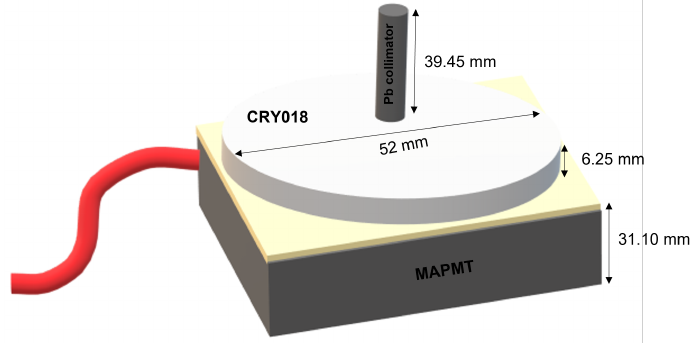
Figure 4. Schematic view of the experimental